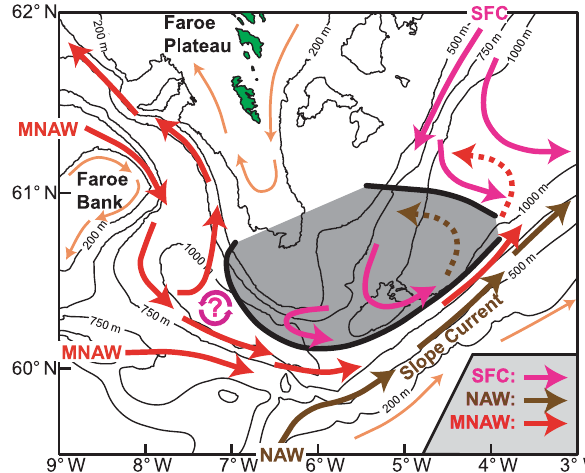
Figure 11. Proposed scheme for the typical passage of Atlantic water through the Faroese Channels. Thin orange arrows indicate flow paths on the shelves and Faroe Bank. Thick coloured arrows show suggested flow paths for three different water masses off the shelves. Grey area indicates the region within which the Midwater Front is typically located (from Fig. 7). The circled question mark indicates possible eddies from the SFC released into the Wyville Thomson